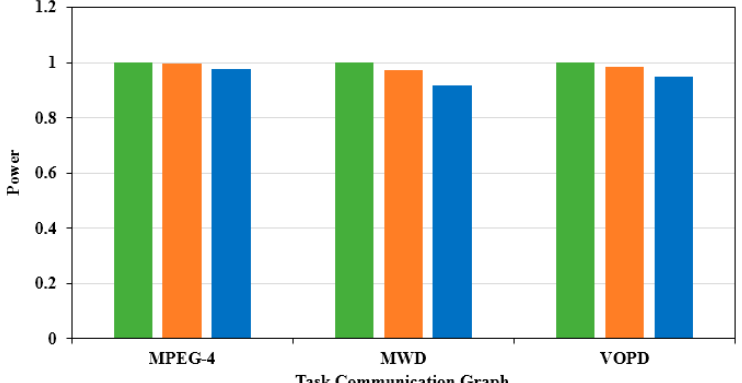
Figure 12. TI_GA, traditional genetic algorithm and ACO for MPEG-4, MWD, VOPD power results comparison ( μ e : μ d = 1:2).